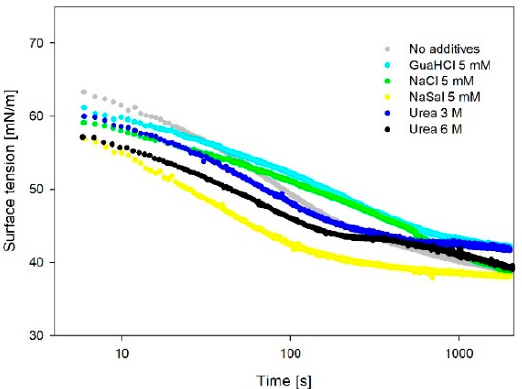
Figure 4. Surface tension of the dispersion of LAE 0.006 wt.% and cCNC 0.3 wt.% with the addition of NaCl, NaSal, GuaHCl and urea.